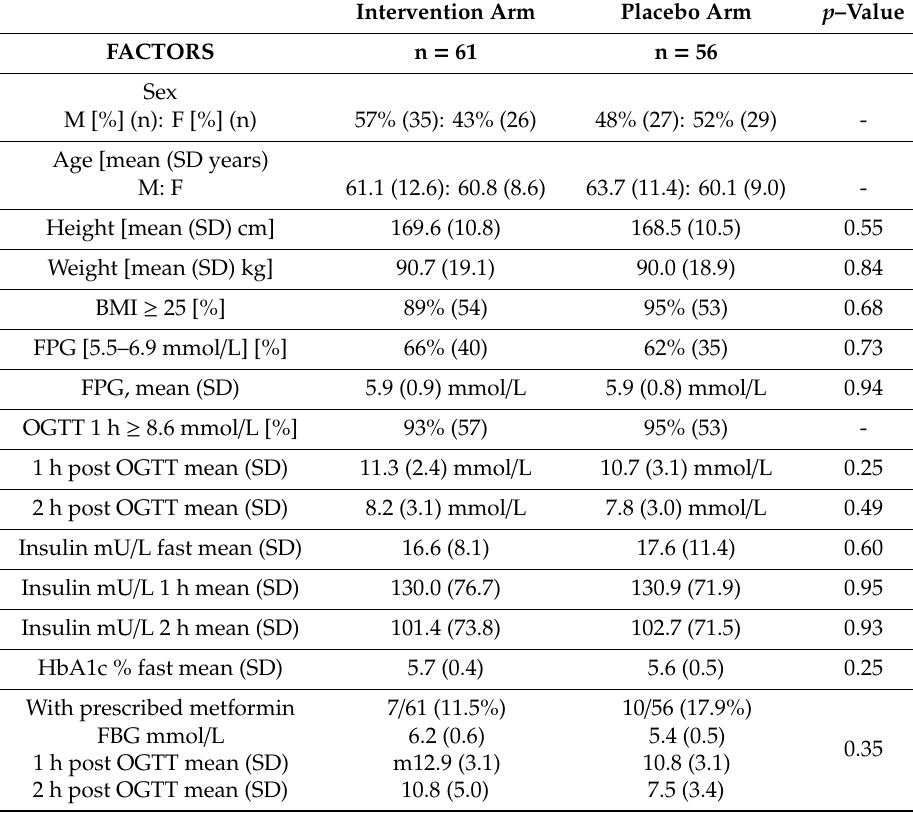
Table 1. Baseline characteristics (full analysis set